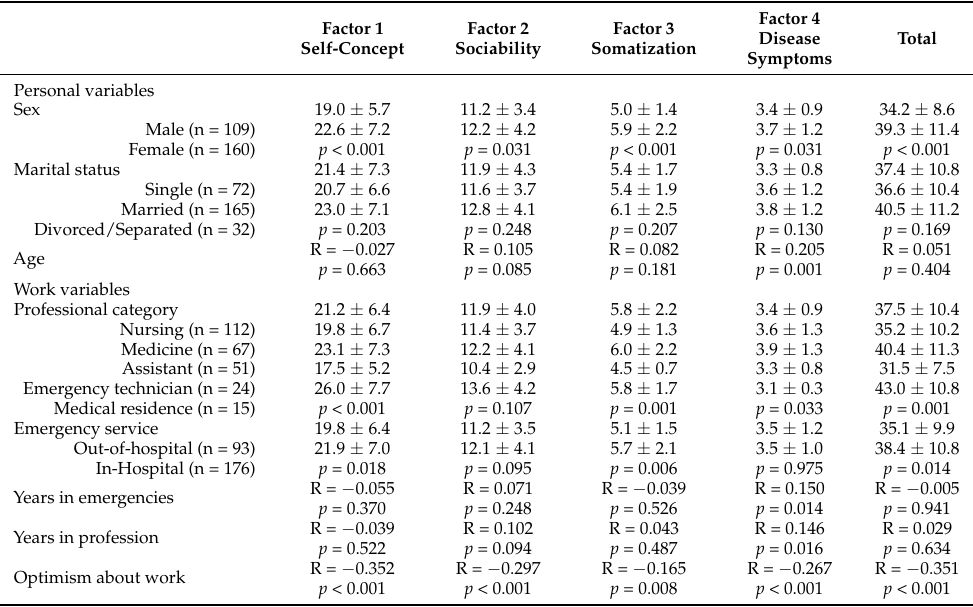
Table 4. Association between the Stress Factors and Manifestations Scale and personal, job, and work optimism